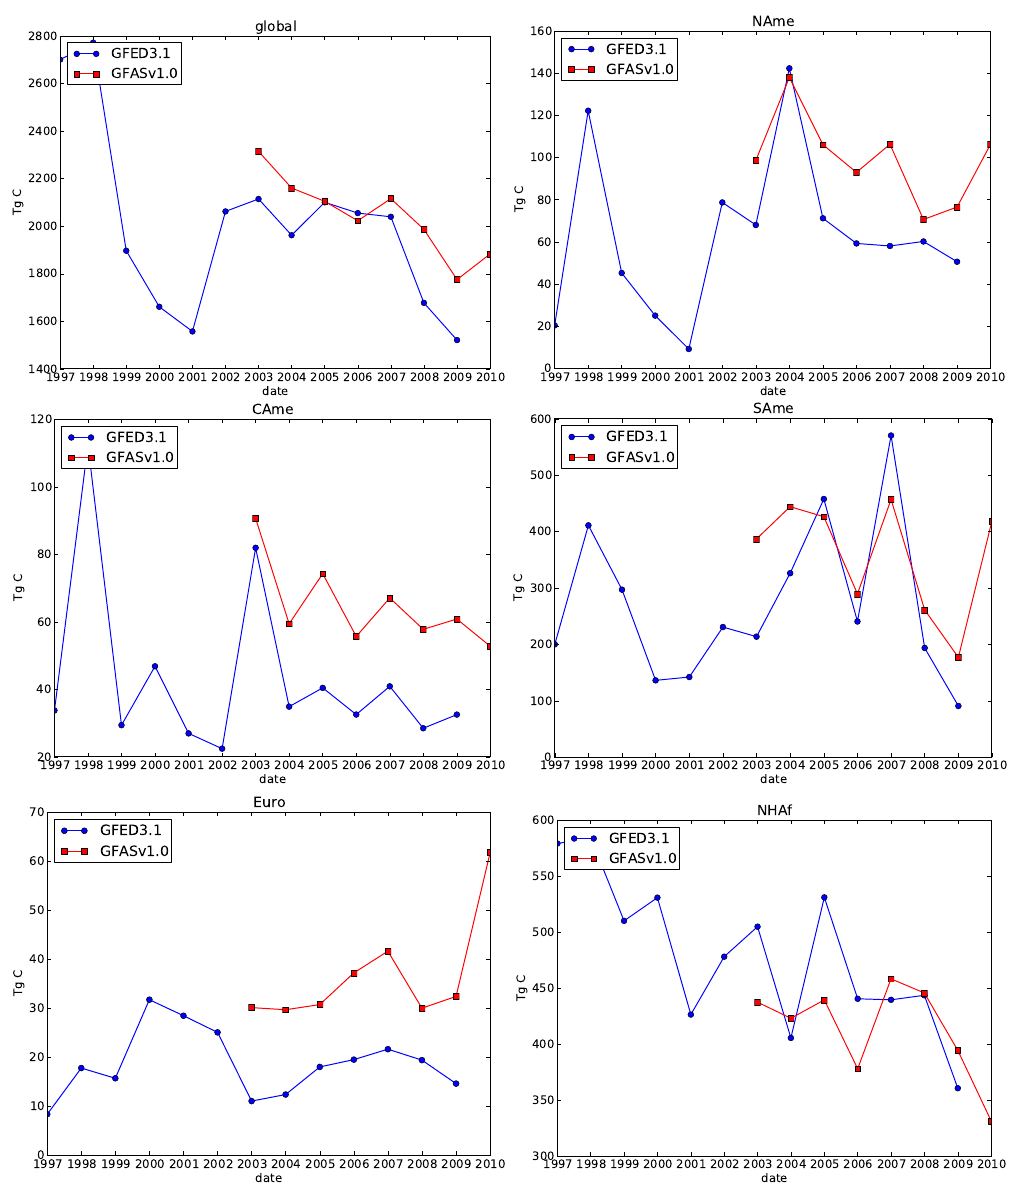
Fig. 7. Annual carbon emissions in GFASv1.0 and GFED3.1 for the entire globe and several regions as defined in Table 4.